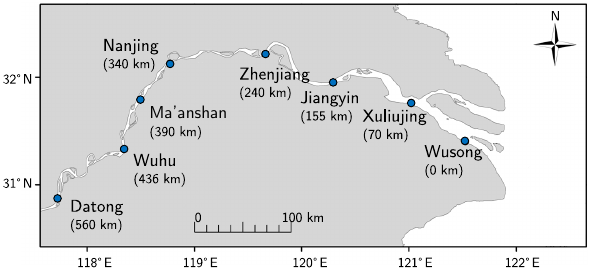
Figure 5. The tidal Yangtze River. Adapted from Guo et al.